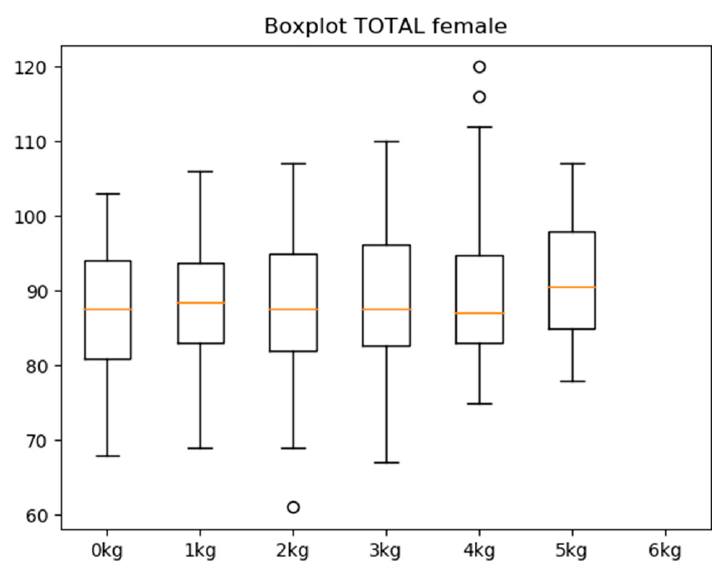
Figure 3. Variability of joint width by weight (female).